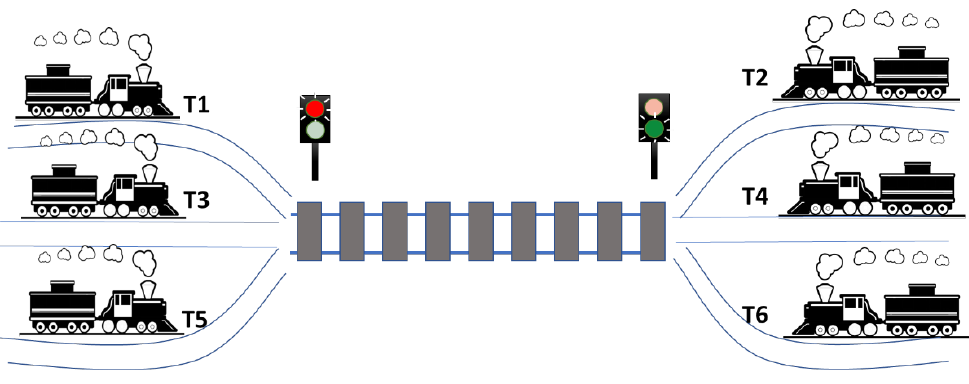
Figure 9. General idea of the DUT employed in the current work.